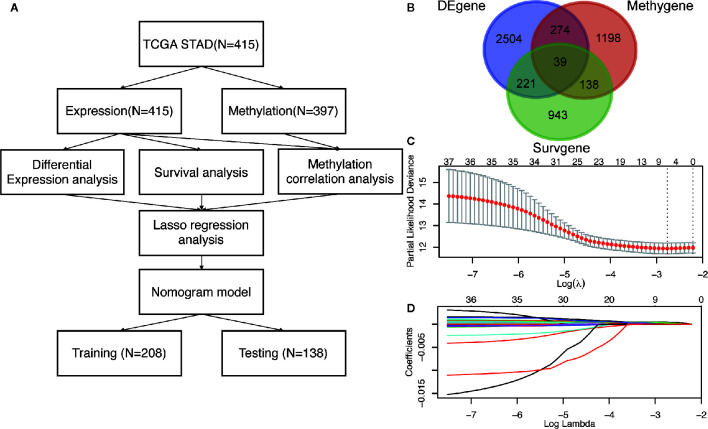
The identification of DNA methylation-driven genes in GC. (A) The work-flow in this study. (B) The Venn diagram of the DEgenes, Surgenes and Methygenes in 415 GC patients, of which 39 DNA methylation-driven genes are identified to be associated with overall survival of patients with GC. DEgenes, differentially expressed genes; Surgenes, survival-associated genes; Methygenes, methylation-associated genes. (C) 1000 iterations of Cox LASSO regression with 10-fold cross-validation is conducted to reduce the number of DNA methylation-driven genes. (D) A total of 5 DNA methylation-driven genes with nonzero coefficients are selected as candidate predictors.